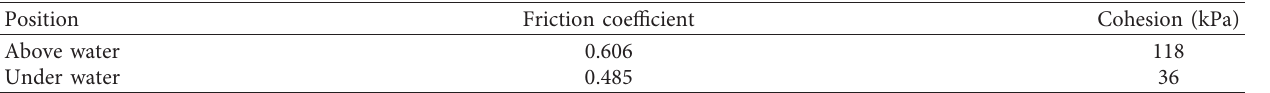
Table 6: Results of the particle size analysis test of the sliding zone